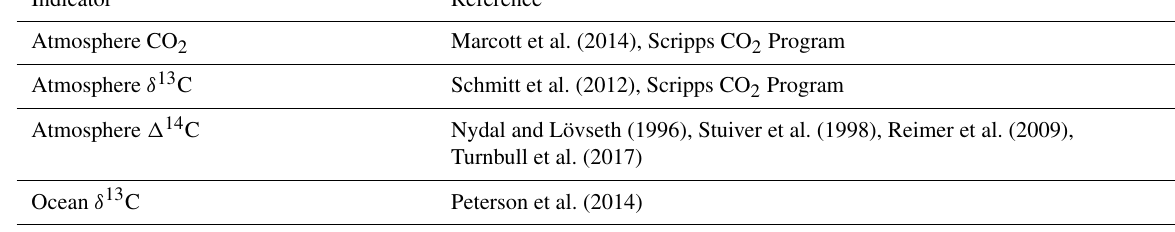
Table 2. Ocean and atmosphere data sources for the SCP-M modern carbon cycle calibration, projections and LGM–Holocene experiment.